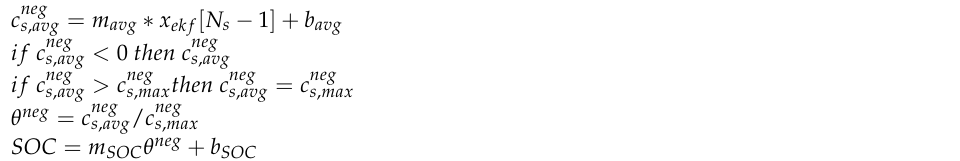
Algorithm 2: Compute SOC and lithium concentration based on the state time